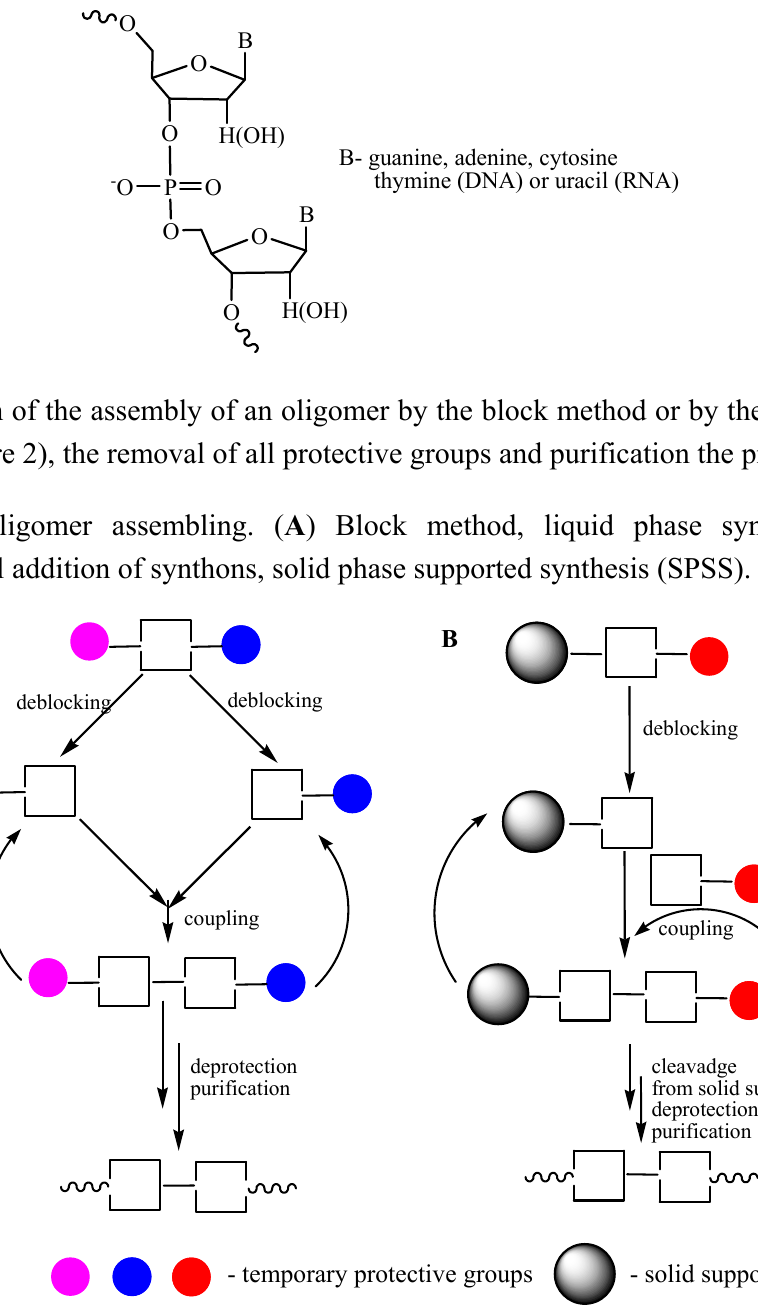
Figure 1. Fragment of a nucleic acid chain.